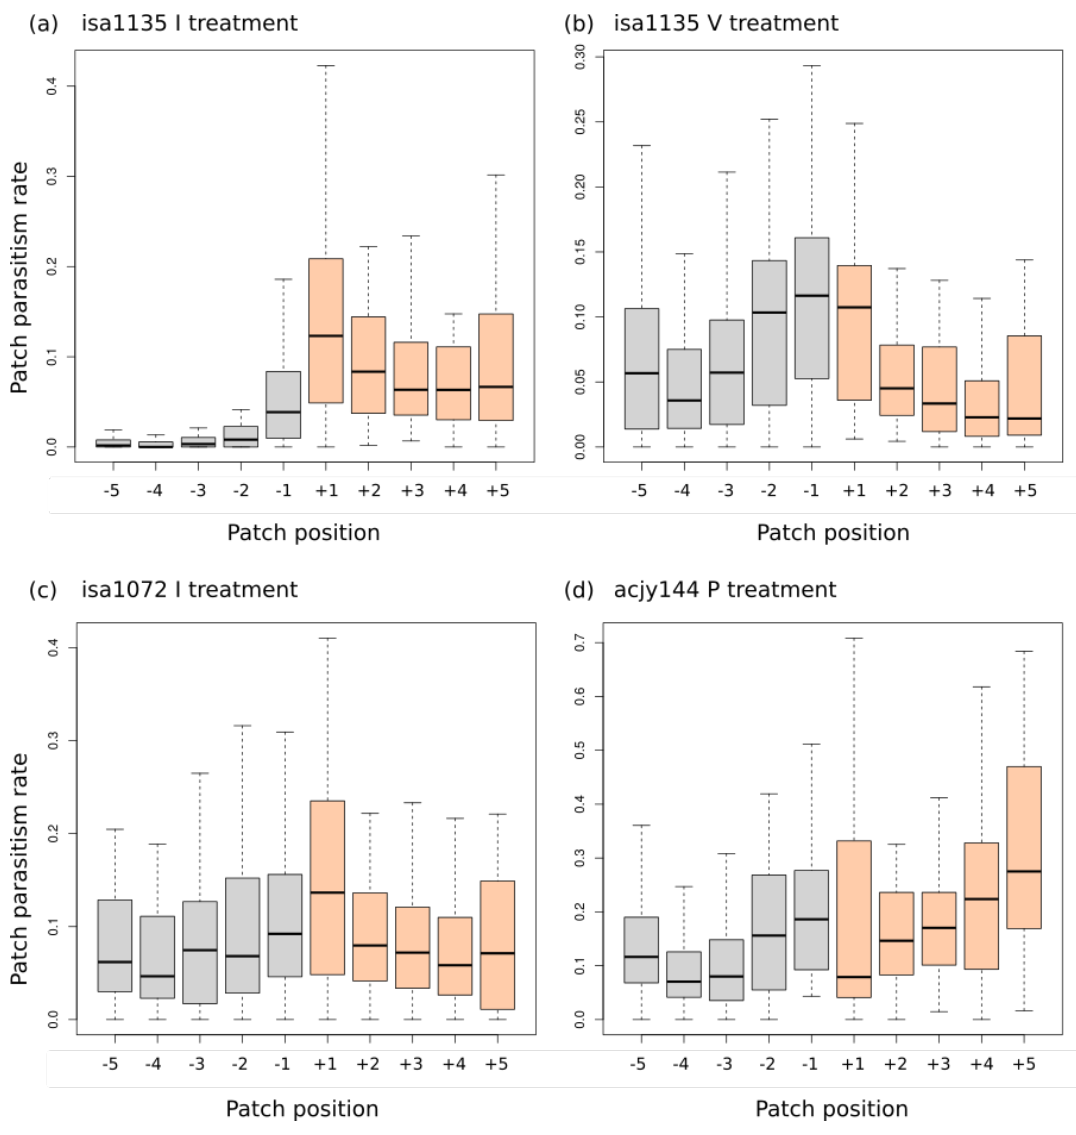
Figure S3. Examples of the distribution of parasitism rate at patch level, along the experimental tubes. Top pan els: population isa1135, on Day 2, in the “I” treatment (a) and the “V” treatment (b). Remark that this population features a clear, atypical, preference for ovipositing in the lower parts. Panel (c): population isa1072, on Day 3, in the “I” treatment. Not e the atypical absence of any particular preference. Panel (d): population acjy144, on Day 3, in the “P” treatment. This is the example shown in Figure 3a, that features a very pronounced “relaxation effect” over consecutive days. Positive patch numbers (in orange) are on the side for which a preference is expected (well-lit and in upward positions in “I”, upward positions in “G”, well - lit positions in “P"). Table S1. Loadings for the principal component analysis presented in Figure 5. The PCA was performed using function prcomp in R, based on estimates from the linear mixed-models. PC1 PC2 PC3 Proportion of variance 0.5111 0.433 0.05554 “P” loading -0.6310106 0.7143917 -0.3024402 “G” loading -0.4131820 -0.6394478 -0.6483727 “I” loading -0.6565868 -0.2841671